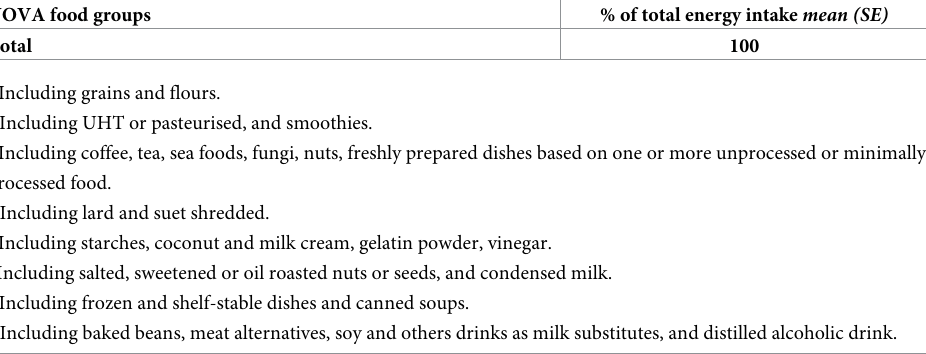
Table 2. Ultra-processed food consumption was higher among men, those with white British ethnicity and smokers, but lower with increasing age and in higher social class groups. The prevalence of obesity was 26.4%, which increased with age and among those on a diet.